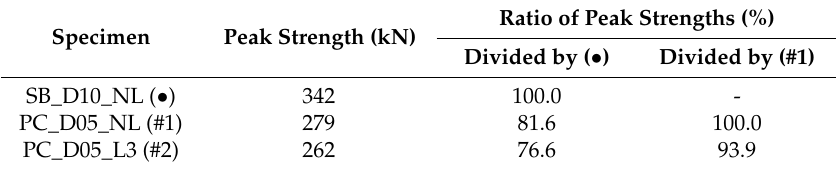
Table 9. Effect of the number of L ‐ shaped plates for PC_D10 specimens.